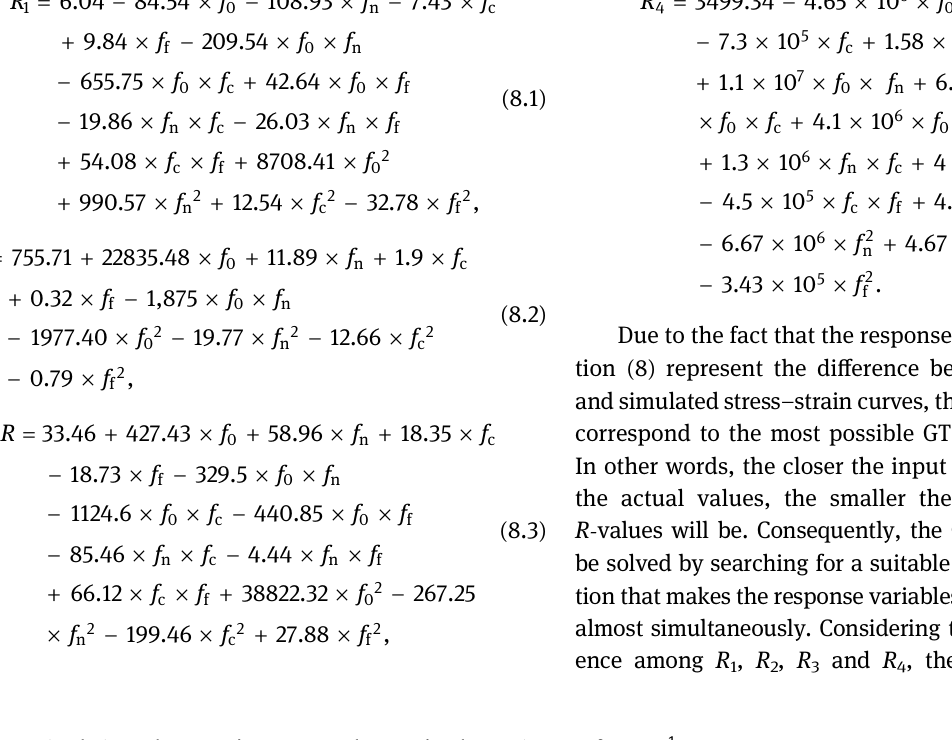
Table 3: Simulation scheme and response values under the strain rate of 0.01 s − 1